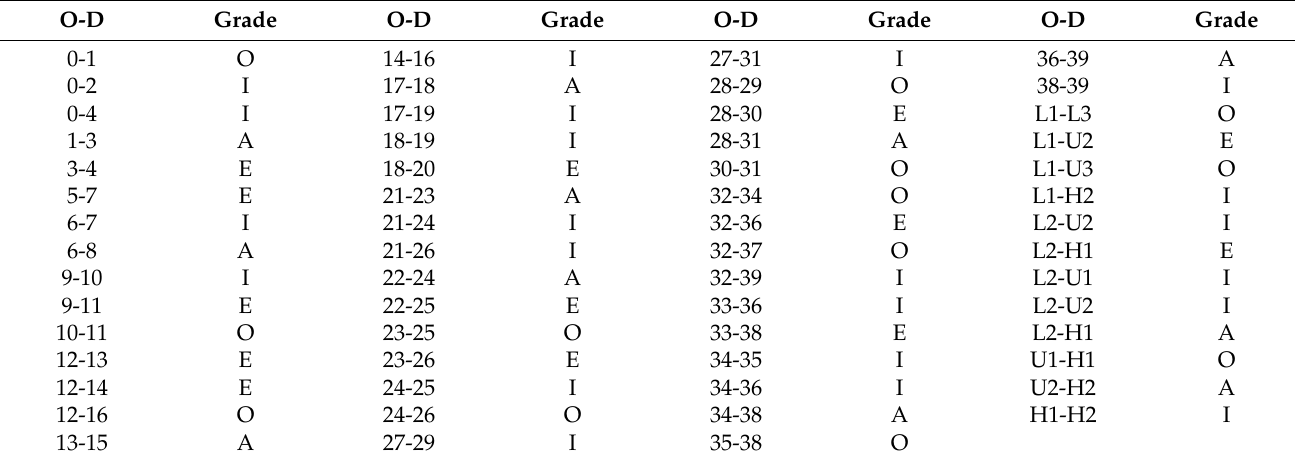
Table 3. Non-logistics